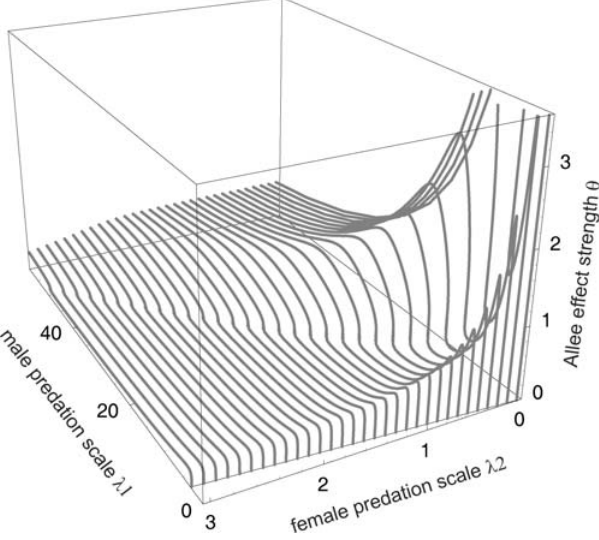
Figure 5. Combined effect of predation rates and the Allee effect in the prey in unscaled model (1). The curves trace a surface separating stable (below) and unstable (above) dynamics; points with l 1 = l 2 (shown for h =0, thin line bottom front) separate male- and female-biased predation. Other parameters as in Fig.